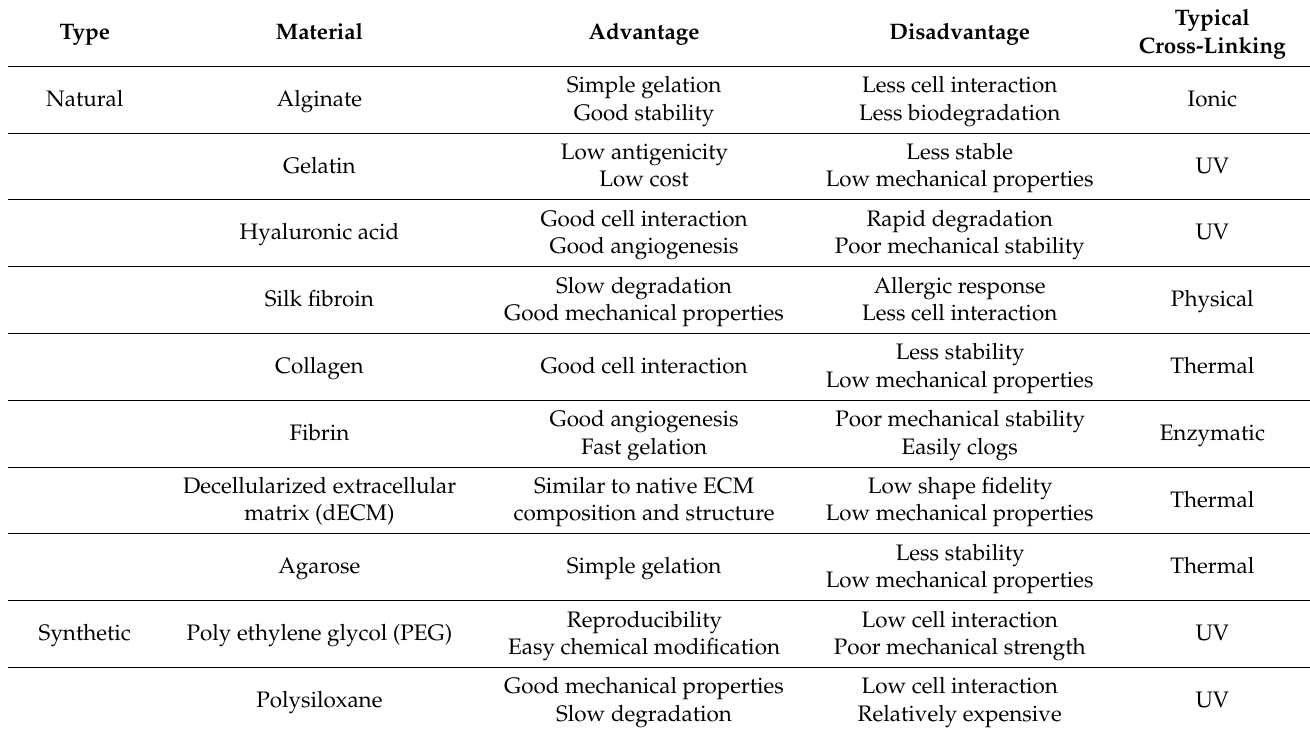
Table 3. Natural and synthetic polymer candidates as bioinks in biomedical